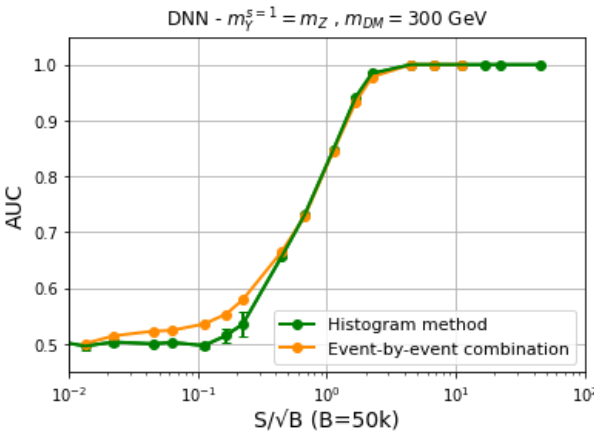
Figure 19: AUC results for the off-shell spin 1 benchmark point using the histogram method (same as in Fig. 7), and combining the outputs of the corresponding event- by-event DNN found in Section 3.1 (see Ref. [ 48 ] for more